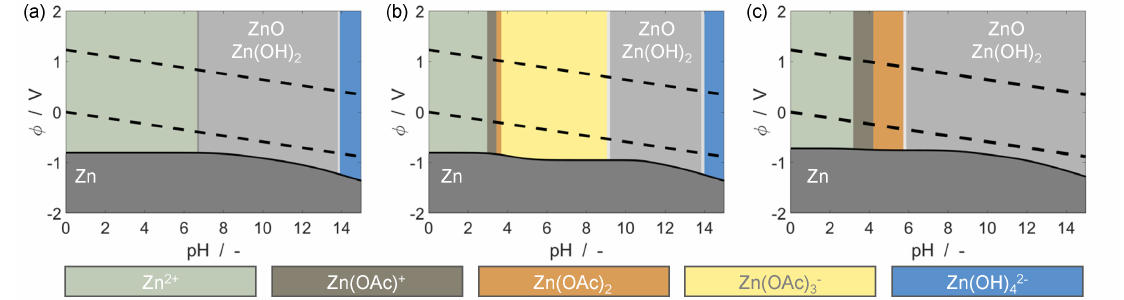
Figure 2. Pourbaix diagrams of Zn in simplified aqueous solutions containing ( a ) no acetate, and 0.01 M total dissolved Zn, ( b ) 13.87 M total dissolved acetate, and 0.01 M total dissolved zinc, and ( c ) 13.87 M total dissolved acetate, and 6.935 M total dissolved zinc. Dashed lines indicate the electrochemical stability window of